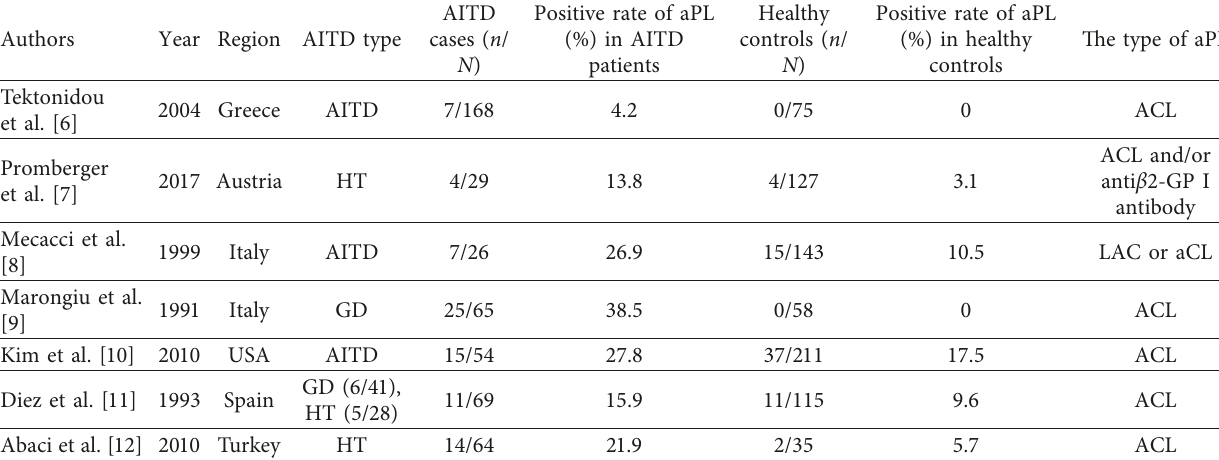
Figure 1: Flowchart of study inclusion and exclusion. Table 1: Characteristics of the included studies in this meta-analysis.